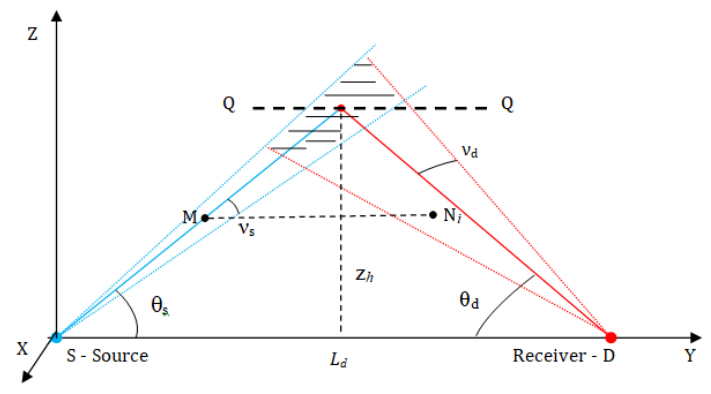
Figure 2. Geometric scheme of channels of bistatic coplanar communication.